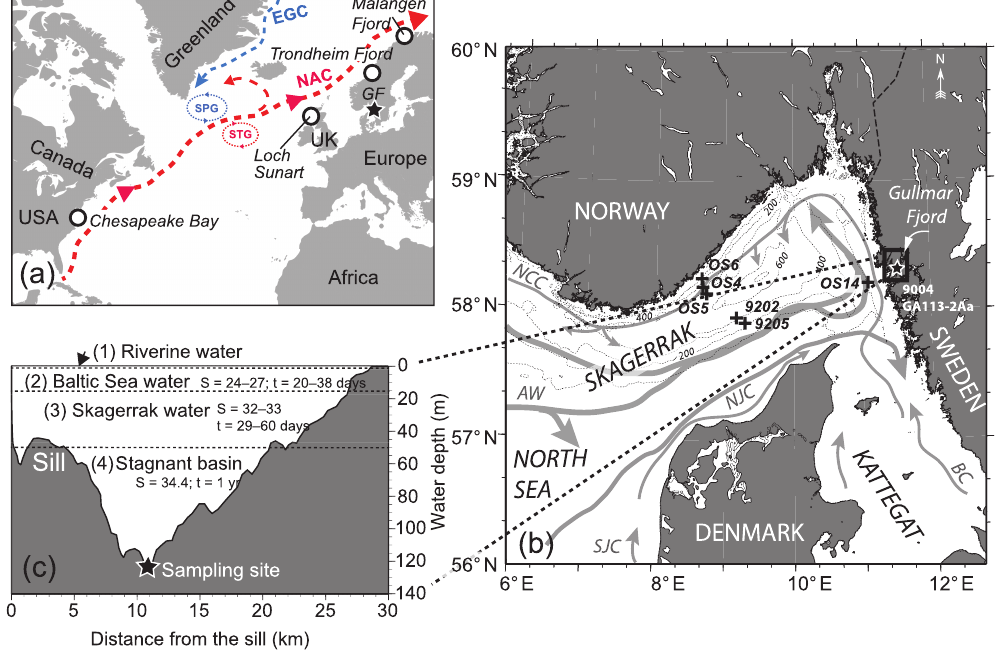
Figure 1. Map of the study area including the location of Gullmar Fjord (GF) and the sampling site for the Ga113-2Aa and 9004 records (star) within the North Atlantic (a) and North Sea – Skagerrak regions (b) . Locations of the other proxy records discussed in the text are shown by white circles, while some of the major ocean circulation characteristics mentioned in the text are indicated as follows: EGC is the East Greenland Current, NAC is the North Atlantic Current, SPG is the subpolar gyre and STG is the subtropical gyre (a) . (b) The major regional water masses and currents are shown as follows: AW is the Atlantic Water, SJC is the South Jutland Current, NJC is the North Jutland Current, BC is the Baltic Current and NCC is the Norwegian Coastal Current. (c) An overview of the water column stratification in the longitudinal profile of the Gullmar Fjord with an indication of the salinity ( S ) and residence times ( t ) typical for each water layer (Arneborg,